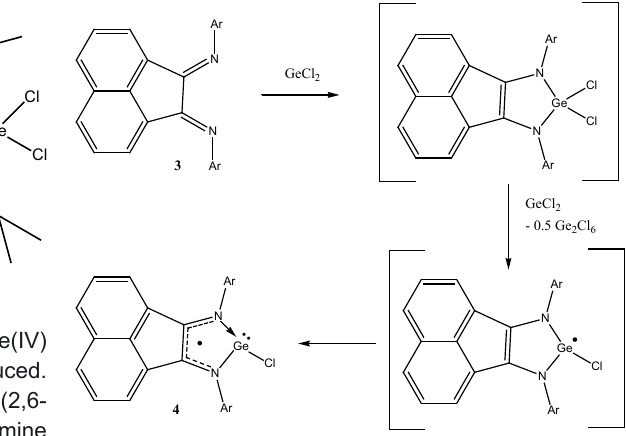
Scheme 5. Synthesis of the radical germylene 4 .